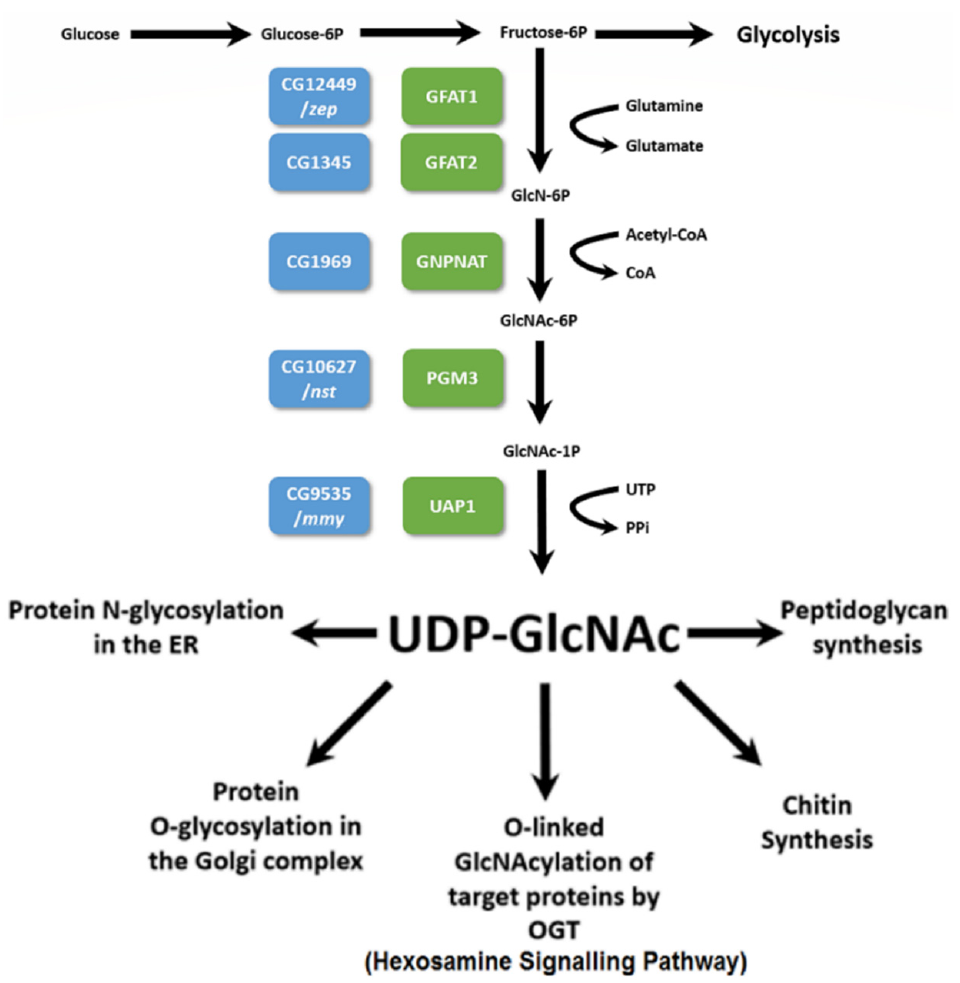
(Figure 1) [1–4]. The rate-limiting step in the pathway is catalyzed by Glutamine-fructose- 6-phosphate transaminase 1 or GFPT1 in humans (hereafter called hGfat1) and Gfat1 in Drosophila, and Glutamine-fructose-6-phosphate transaminase 2 or GFPT2 in humans (hereafter called hGfat2) and Gfat2 in Drosophila. In Drosophila, C . elegans , mice, and humans, Gfat1 and Gfat2 are encoded by two separate genes, and this may also be the case for Aedes aegypti [5–8]. In contrast, it appears that there is only a single Gfat gene/enzyme in fungi [9–11]. The distinction between hGfat1 and hGfat2 is the presence of two puta- tive Protein Kinase A (PKA) sites in hGfat1, but only a single site in hGfat2 [5,12,13]. In Drosophila melanogaster , one of the PKA sites is conserved in both Gfat1 and Gfat2. Although the other site is partially conserved (albeit presumably non-functional) in Gfat1, it is absent from Gfat2 [5].